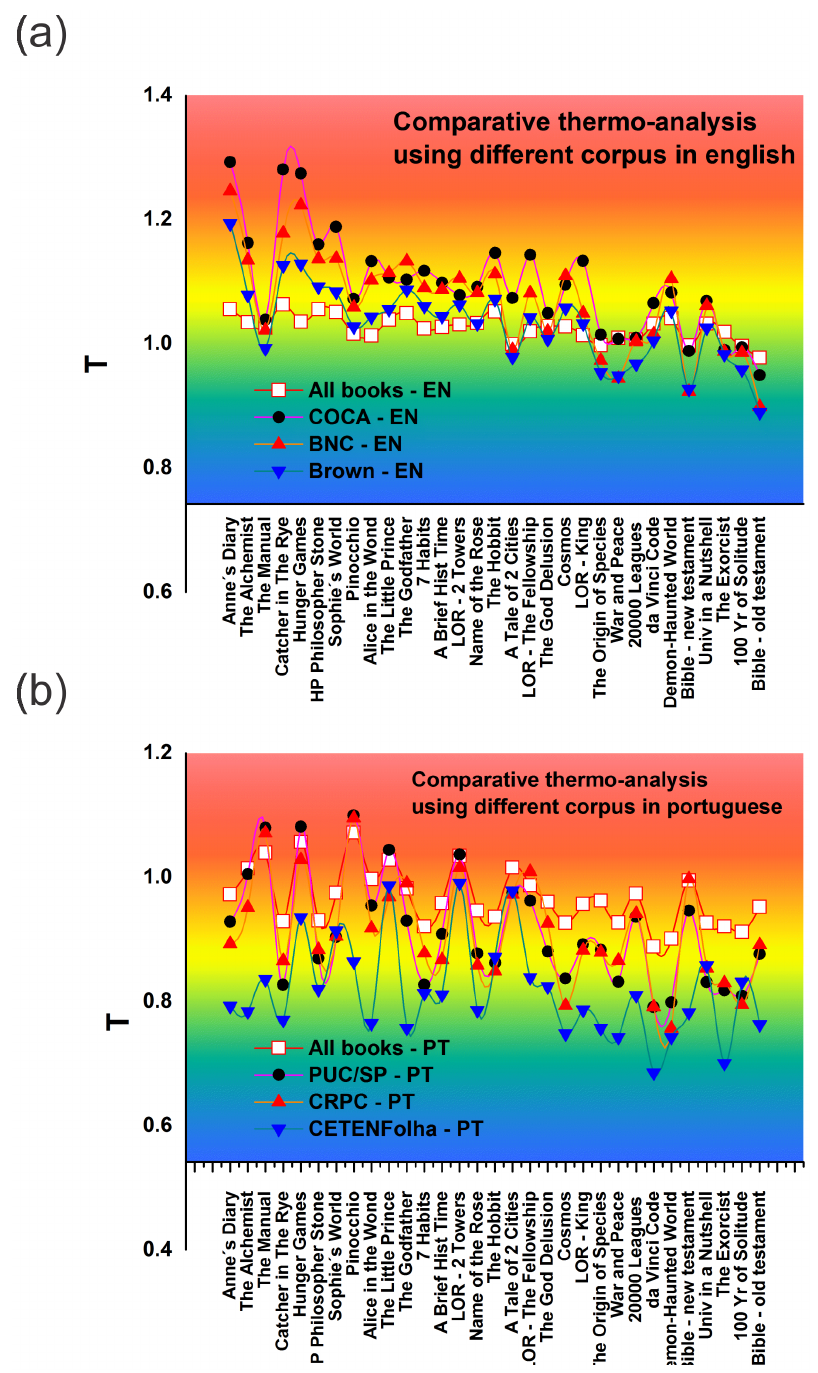
Figure 5. Corpus dependence of the book Temperatures. Plots of the characteristic temperature for books by increasing order for different corpus in (a) English and (b) Portuguese. The Figure 2(b) shows a plot of the energy distribution of words for several translated versions of The da Vinci Code and their respective temperatures calculated from their slopes (e.g., the slope for the Portuguese translation is approximately { 1 : 26 , corre- sponding to T pt ~ 0 : 79 , and so on). To allow a comparison between languages, we use T st ~ 1 : 00 as the ‘‘standard tempera- ture’’ for each corpus.